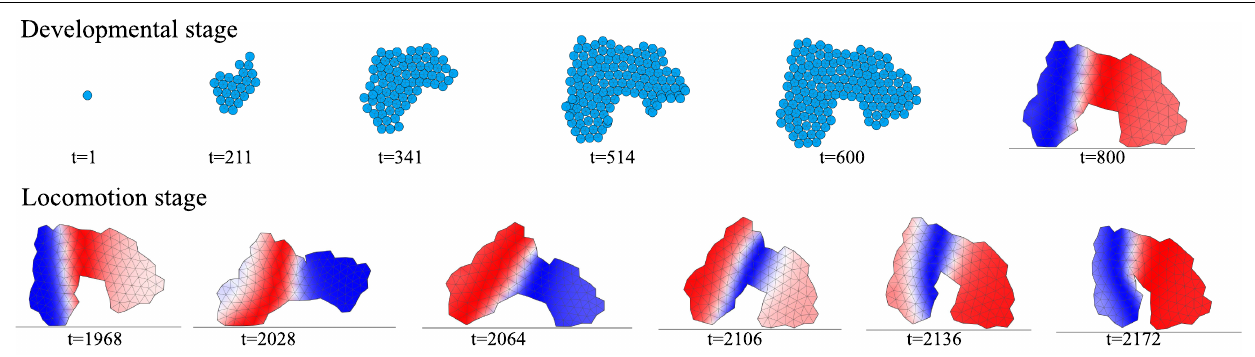
FIGURE 1 | Example life cycle (evaluation process) of an evolved animat . The upper row shows developmental stage and the transition from multicellular representation of an embryo to the physical model of an animat that occurs at the beginning of the locomotion stage. The bottom row shows snapshots of the animat in motion, during the locomotion stage. The animat moves right. Colors indicate temporal contraction of a body region (blue) or expansion (red). Videos for each stage can be found at: http://youtu.be/K 06 FSr 0 hInI and http://youtu.be/JRgnPs 8 e- 5 c.